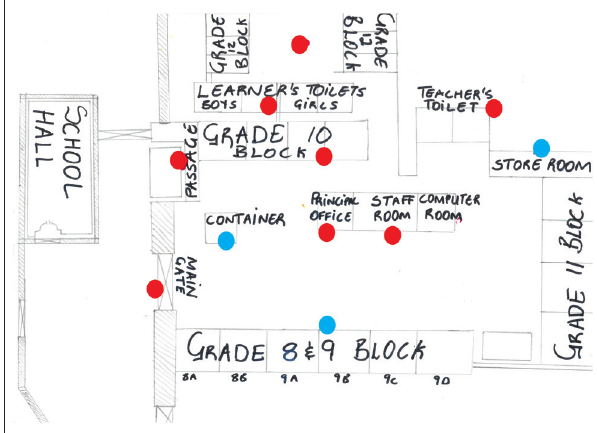
FIGURE 2: The participants collaboratively drew this figure to depict bullying danger zones and safe places in the school. The red dots denote bullying danger zones and the blue ones denote safe